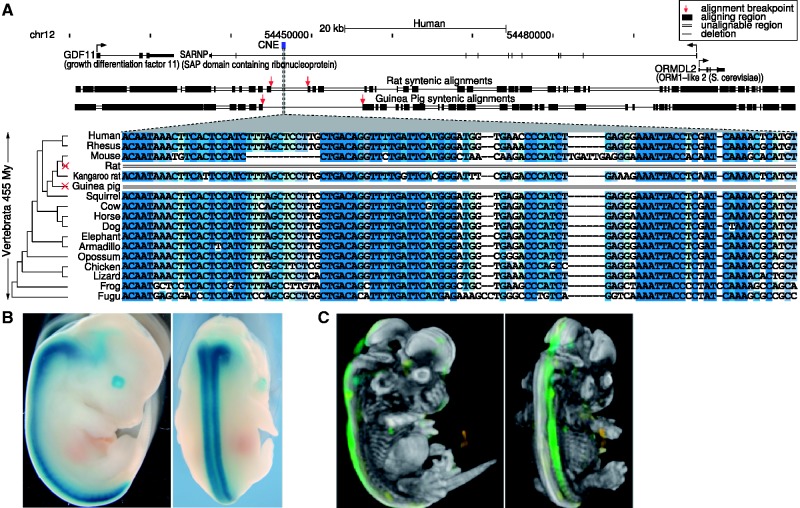
An independently lost CNE is a transcriptional enhancer in development. (A) The CNE is lost independently in the rat and guinea pig lineage (lacking any sequence similarity to the genome and all unassembled traces) but is conserved over ∼450 My of vertebrate evolution. The top part shows the location of the CNE (blue) in the human genome together with the exon–intron structures of the surrounding genes (arrows indicate the transcription start site). Below is a graphical representation of pairwise genome alignments to rat and guinea pig showing that the genes but not the CNE align to both species. Syntenic aligning regions in rat and guinea pig are shown as black boxes, a single line indicates a deletion between aligning blocks and a double line indicates that the region contains sequence that does not align. Red arrows mark the ends of the up- and downstream aligning blocks and suggest that independent events led to the CNE loss in rat and guinea pig. The bottom part shows the sequence alignment where darker blue shades indicate higher sequence identity in an alignment column. (B) A transcriptional enhancer assay in transgenic mouse embryos reveals lacZ reporter expression, showing that the CNE is a spinal cord enhancer at embryonic day 13.5 (7 out of 7 embryos). (C) The expression pattern in (B) is consistent with in situ hybridization data of GDF11 at embryonic day 13.5, suggesting that this CNE is a regulatory element for GDF11. Data from Image Series 100047449, Allen Developing Mouse Brain Atlas, Seattle (WA): Allen Institute for Brain Science. ©2009. http://developingmouse.brain-map.org.